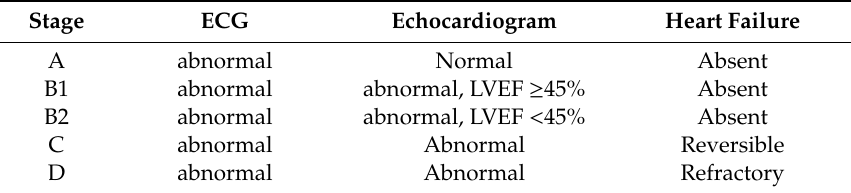
Table 1. Definition and progression of chronic Chagas heart